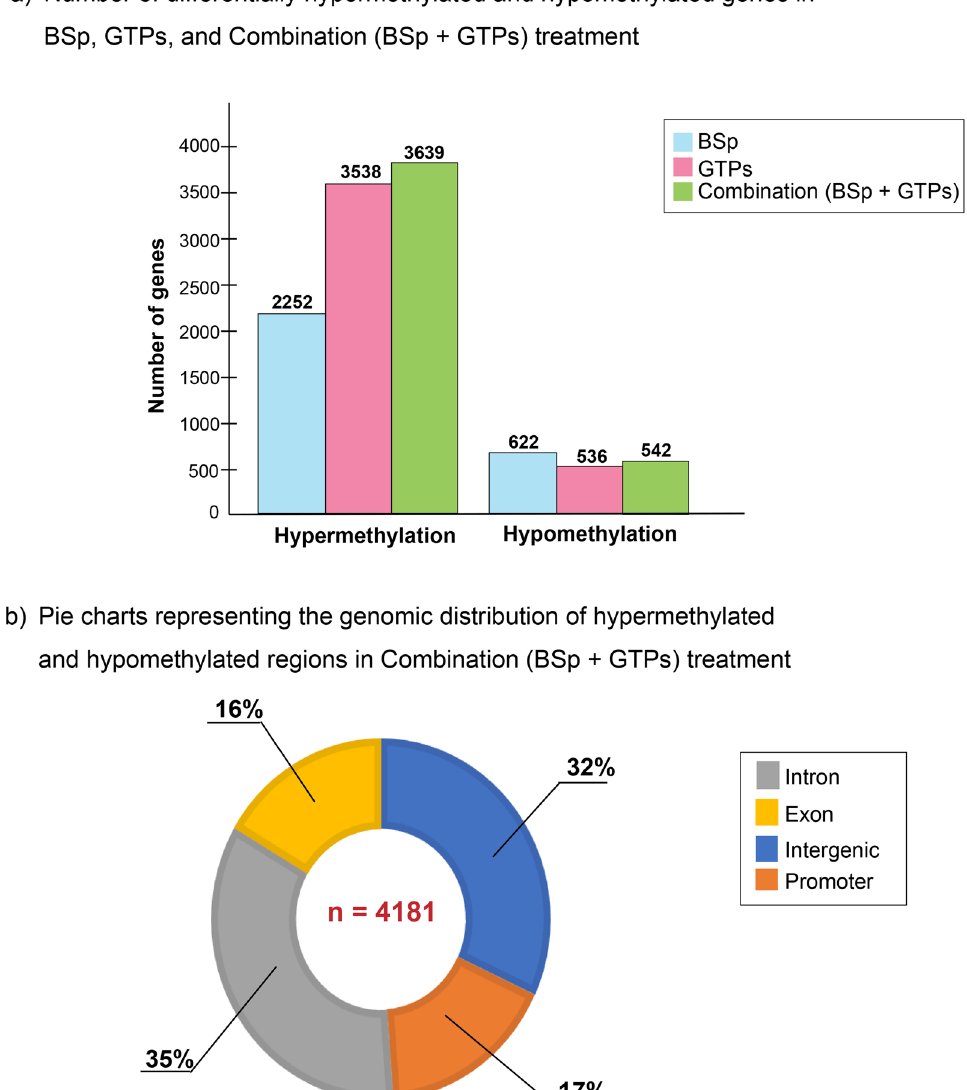
Figure 5. Differential DNA methylation analyses by RRBS across different treatment groups. ( a ) Bar plot representing different numbers of differentially hypomethylated and hypermethylated genes in BSp, GTPs and the combination (BSp + GTPs) treatment groups. The height in the bar plot represents the total number of differentially methylated genes in BSp (blue color), GTPs (pink color) and the combination (green color) treatment groups. ( b ) Pie charts representing the genomic distribution of hypo- and hypermethylated regions in the combination treatment (N DMRs = 4181) group. Grey color represents Intronic regions (35%), yellow color represents exonic regions (16%), blue color represents intergenic regions (32%) and orange color represents promoter regions